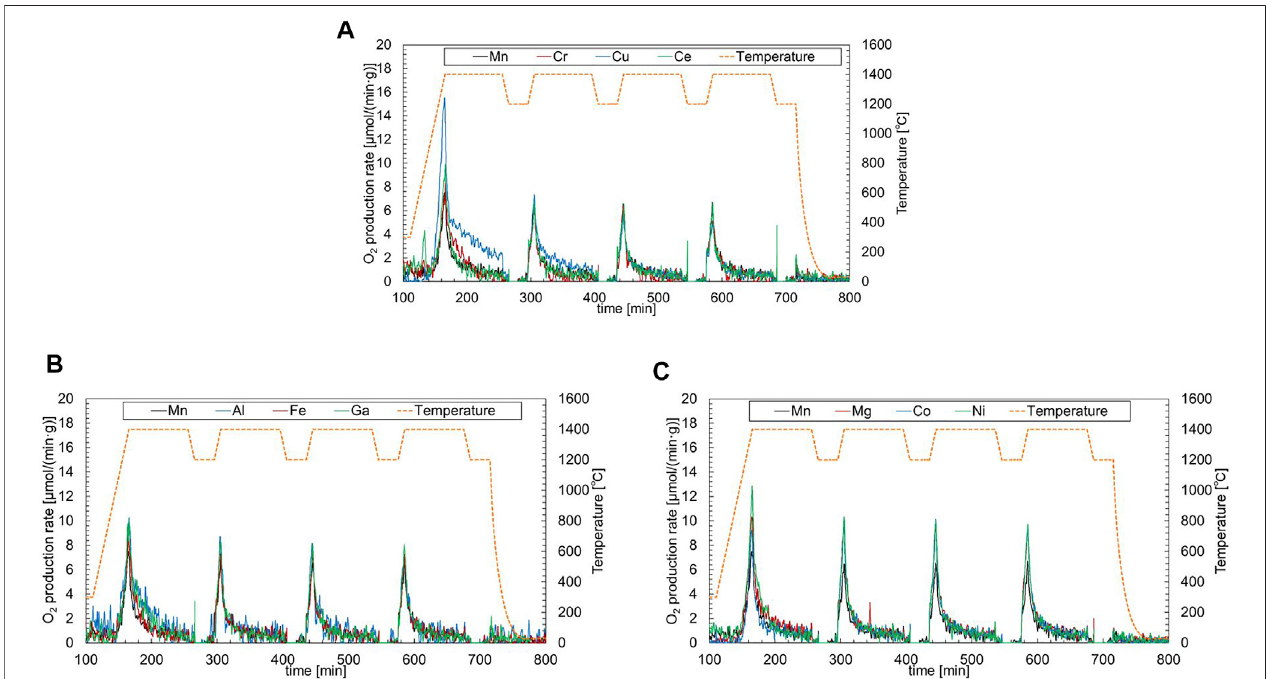
FIGURE4| O 2 productionpro fi lesofsamplesbelongingto (A) groupA(Cu,Cr,andCe-substitutedLSMs), (B) groupB(Fe,Al,andGa-substitutedLSMs),and (C) group C (Co, Ni and Mg-substituted LSMs) during the TR step in the fi rst to fourth runs. The production pro fi les correspond to left Y-axis, while the temperature pro fi le corresponds to right